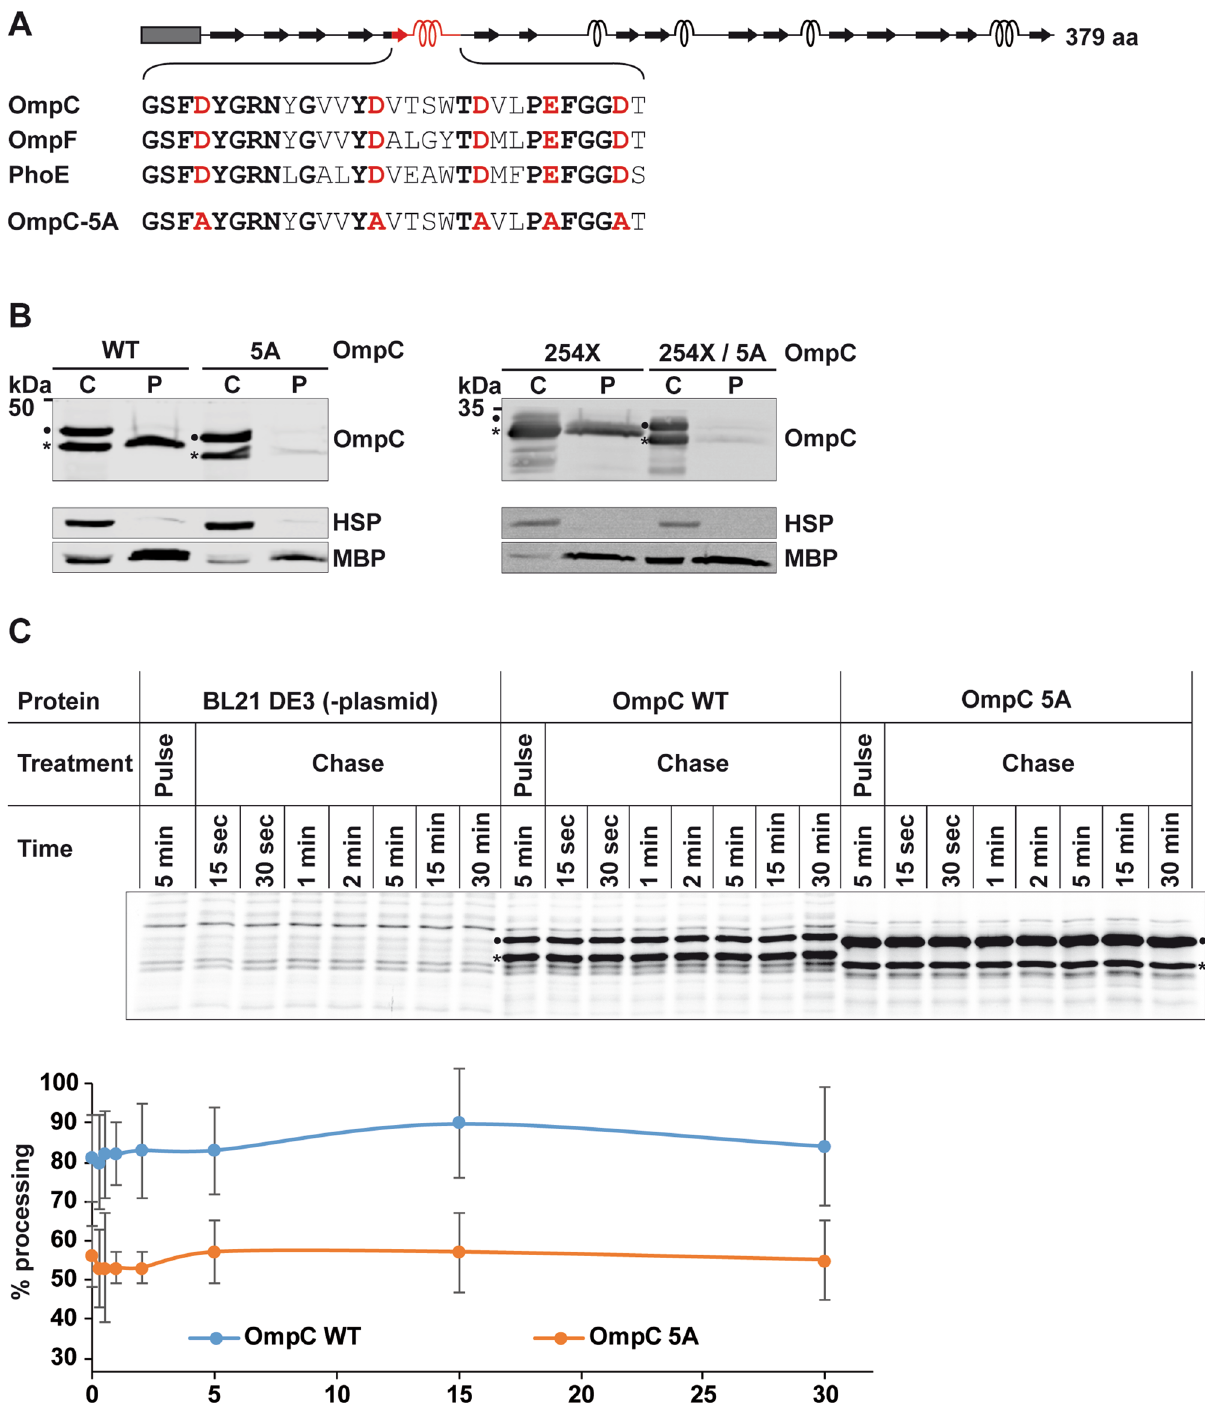
Figure 3. Helix1 of OmpC promotes periplasmic localization in a sequence-dependent manner. ( A ) Schematic presentation of the constructs analyzed. Dark rectangle: signal peptide; arrows indicate beta-strands, α-helical structure is indicated by helices. The amino acid sequences of the conserved motif of OmpC, OmpF and PhoE are shown in the detail magnification. Conserved residues are indicated in bold. The amino acid substitutions of the OmpC5-A variant are marked in red. The total length of the protein is indicated. ( B ) Transformed E. coli cells expressing the proteins indicated were fractionated and the cytoplasmic (C) and periplasmic (P) fraction analyzed by Western blotting. Unprocessed full length constructs ( ) and constructs after signal peptide cleavage ( * ) are marked. Cytosolic heat shock proteins (HSP) and the periplasmic maltose-binding protein (MBP) were analyzed in parallel. Uncropped images ● of representative Western blots can be found in Supplementary Figure 3. ( C ) Pulse chase experiments with E. coli BL21 DE3 expressing the proteins indicated or transformed with empty pET27b vector as control (-plasmid). Cells were labeled with 35 S methionine/cysteine after rifampicin addition, which blocks the endogenous RNA polymerase but not T7 RNA polymerase. After 5 min of pulse, excess non-radioactive methionine/cysteine was added and samples were taken at the indicated time points, separated by SDS-PAGE and analyzed by phosphor imaging. Statistics is shown for at least two biological replicates with two technical replicates each. The error bars represent the standard error of the mean (SEM). Uncropped images of Autoradiogram can be found in Supplementary Figure